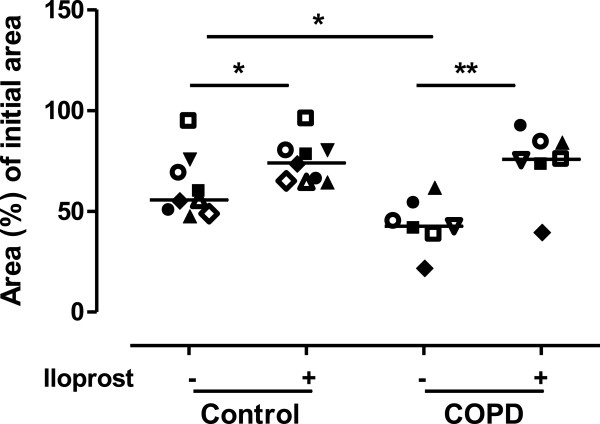
Iloprost reduced fibroblast gel contractions in control and COPD fibroblasts. Fibroblast gel contractions were performed with lung fibroblasts from control subjects (n = 8) and patients with COPD (n = 7). Cells were stimulated with iloprost (1000 nM) in fibroblast medium containing 0.4% serum and indomethacin (3 μM). All gel contraction experiments are the mean of triplicates and measured after 48 h. Data are presented as median with individual values and median values are represented as a line. *p < 0.05; **p < 0.01. Statistical analysis is performed with Mann Whitney test to compare differences between control and COPD fibroblasts and Wilcoxon paired rank sum test is used to analyze differences within the control and COPD fibroblasts after iloprost stimulation.